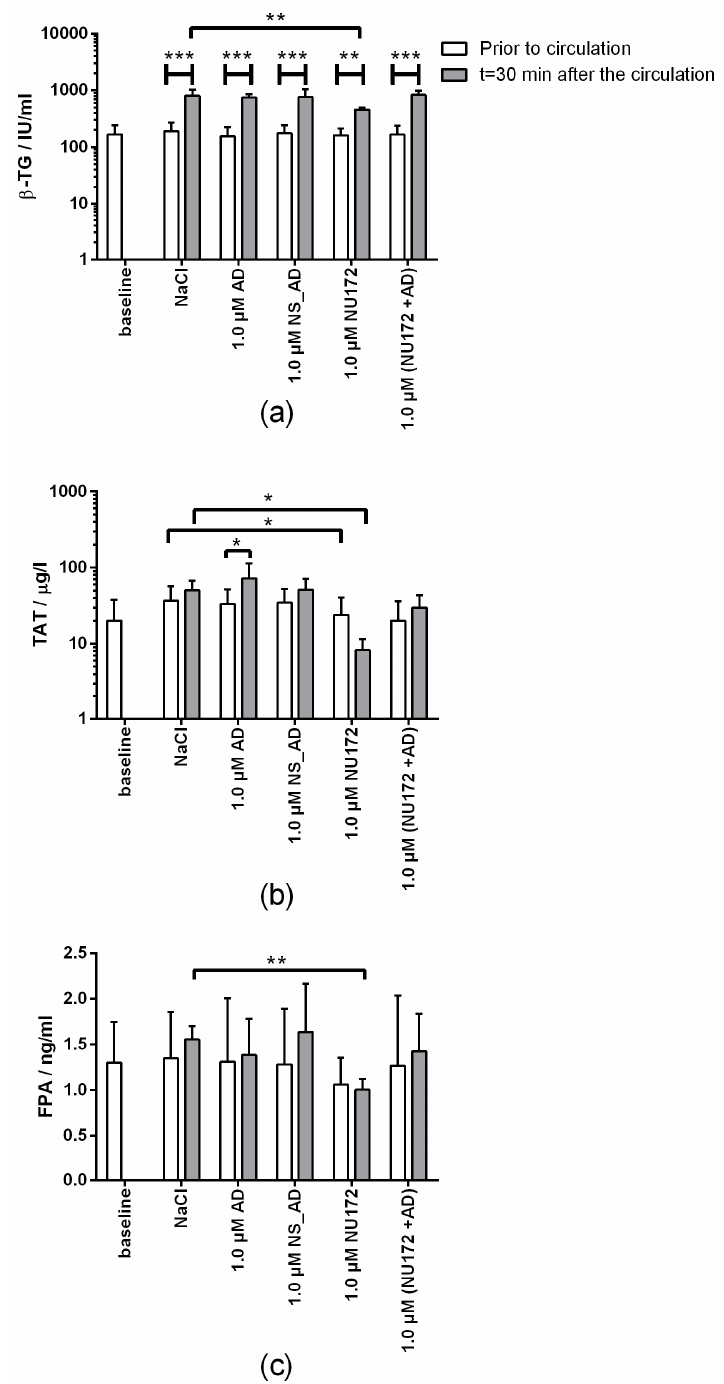
Figure 8. Determination of coagulation activation markers. Heparinized blood with 1.0 µM NU172 or 1.0 µM NU172 and 1.0 µM AD was incubated for 0 and 30 min at 37 °C in an in vitro rotation model. Blood without any addition was indicated as a baseline. Using ELISA, the concentrations of ( a ) β -TG, ( b ) TAT and ( c ) FPA were determined before and after the circulation. Blood from five different volunteers was used (n = 5 ± SD). The statistical analysis was performed using t-test (* p < 0.05, ** p < 0.01, *** p < 0.001).